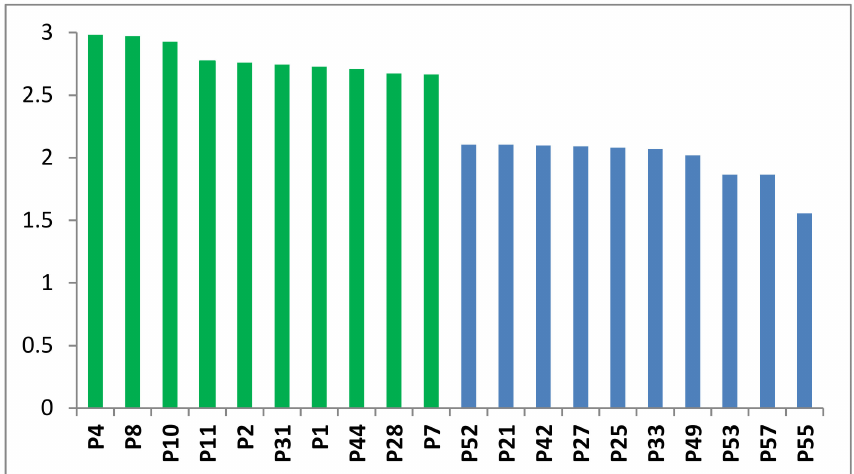
Figure 1. Average ratings of 10 most and 10 least popular practices of proecological behavior in Russia.